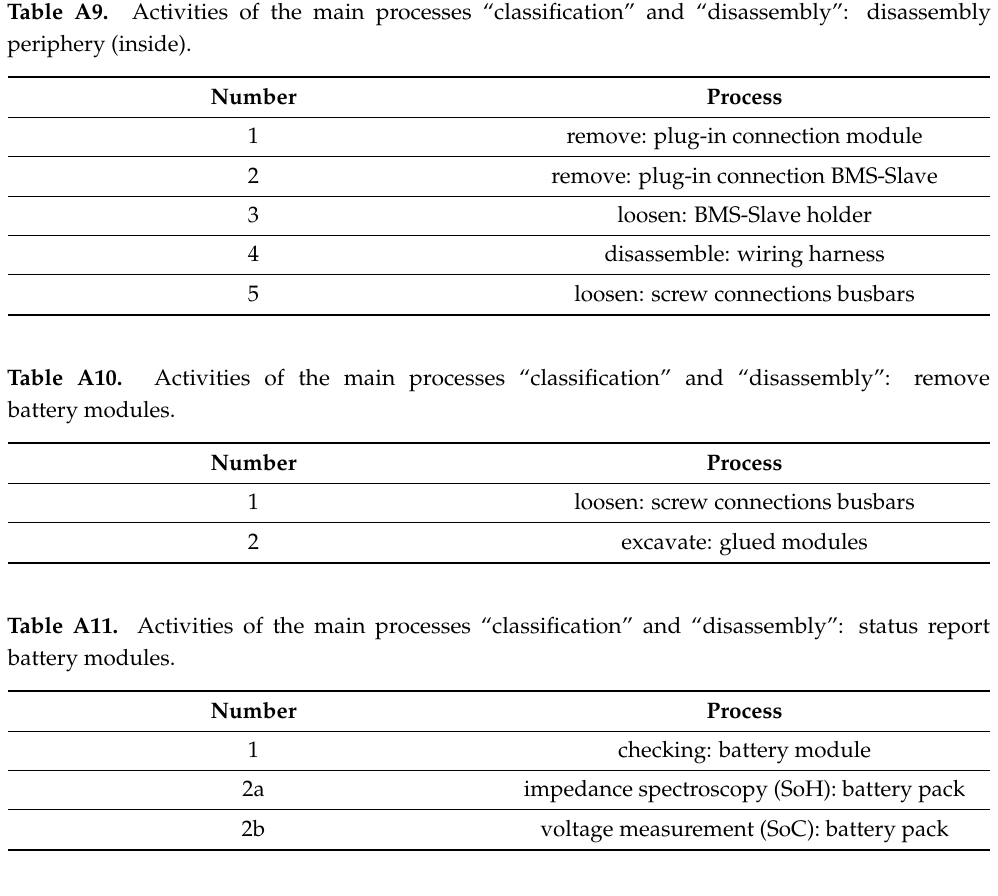
Table A12. Activities of the main application process “repurpose”: assembly energy